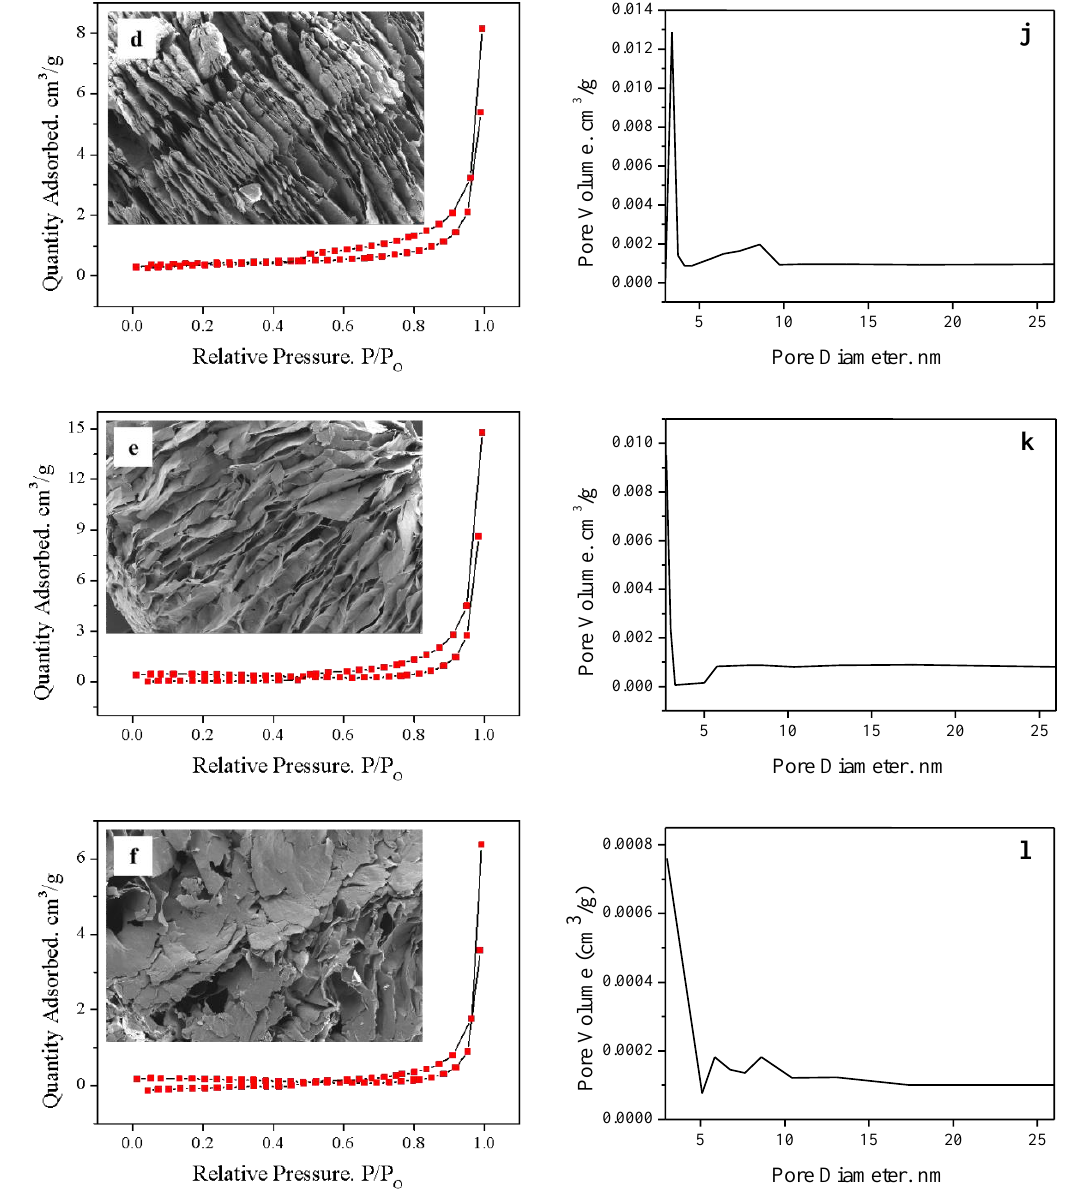
Figure 7. SEM images, N2 adsorption–desorption and pore diameter distribution curves for different solid–liquid ratios: 1:0 ( a , g ), 1:1 ( b , h ), 1:2 ( c , i ), 1:4 ( d , j ), 1:18 ( e , k ), 1:12 ( f , l ).